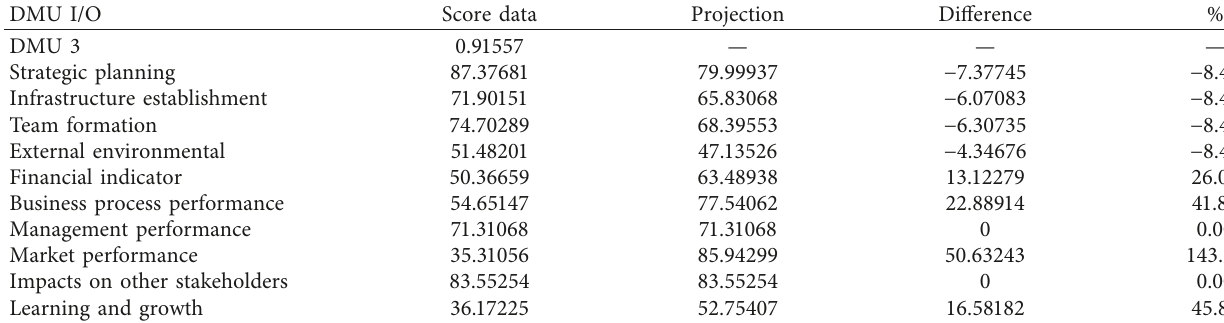
Table 12: Specific improvement measures for DMU3.